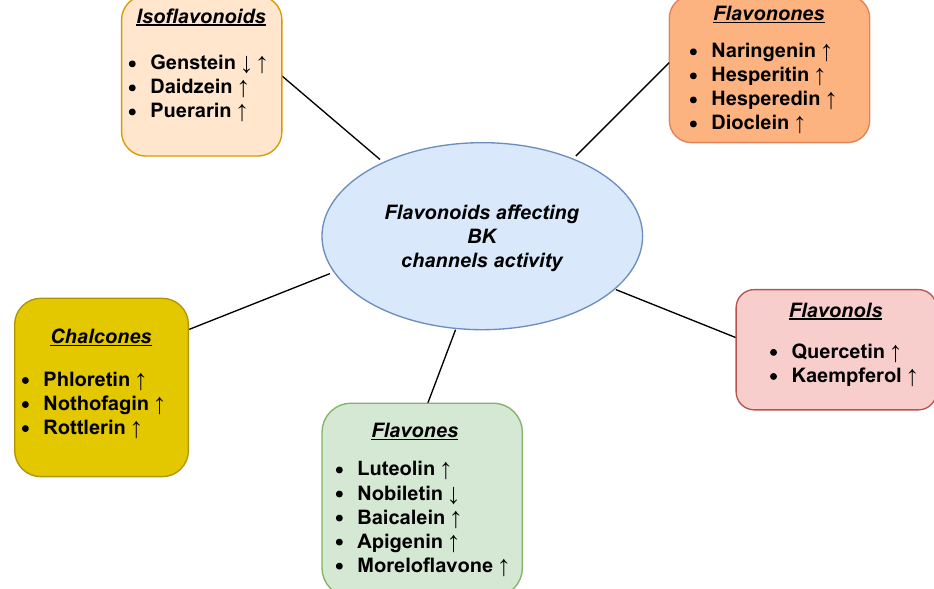
Figure 1. The schematic summary of the impact of key representatives of the main groups of flavonoids on the activity of the BK channels. Arrow up corresponds to the increase of the open state probability. Arrow down denotes channel inhibition. Both arrows represent the case when different types of channel modulation were reported depending on the cell types where the investigated BK channels were